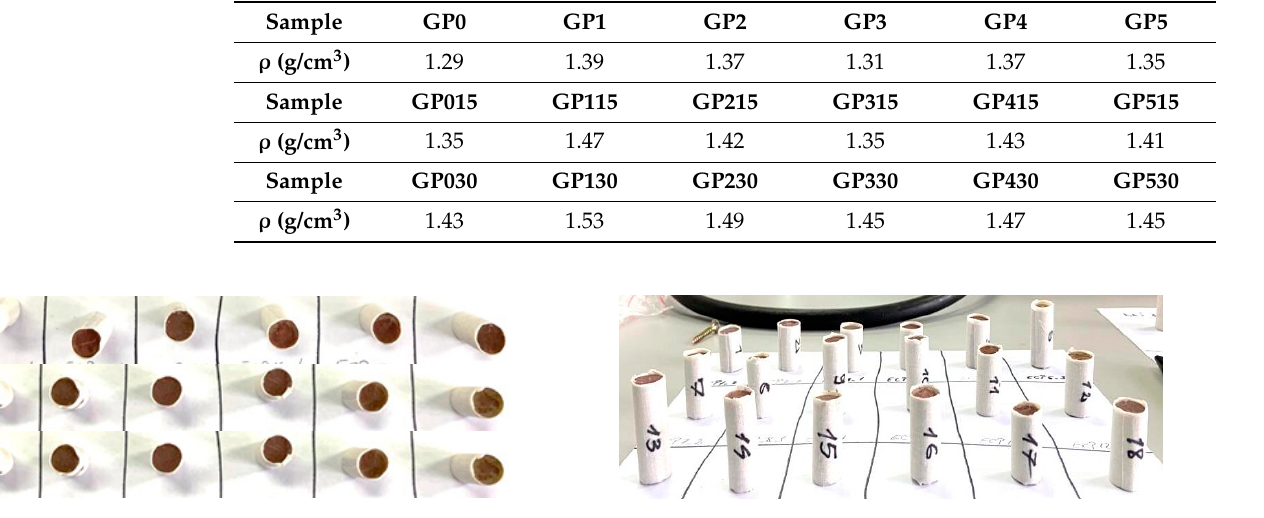
Table 5. Loading density values for the developed formulations.